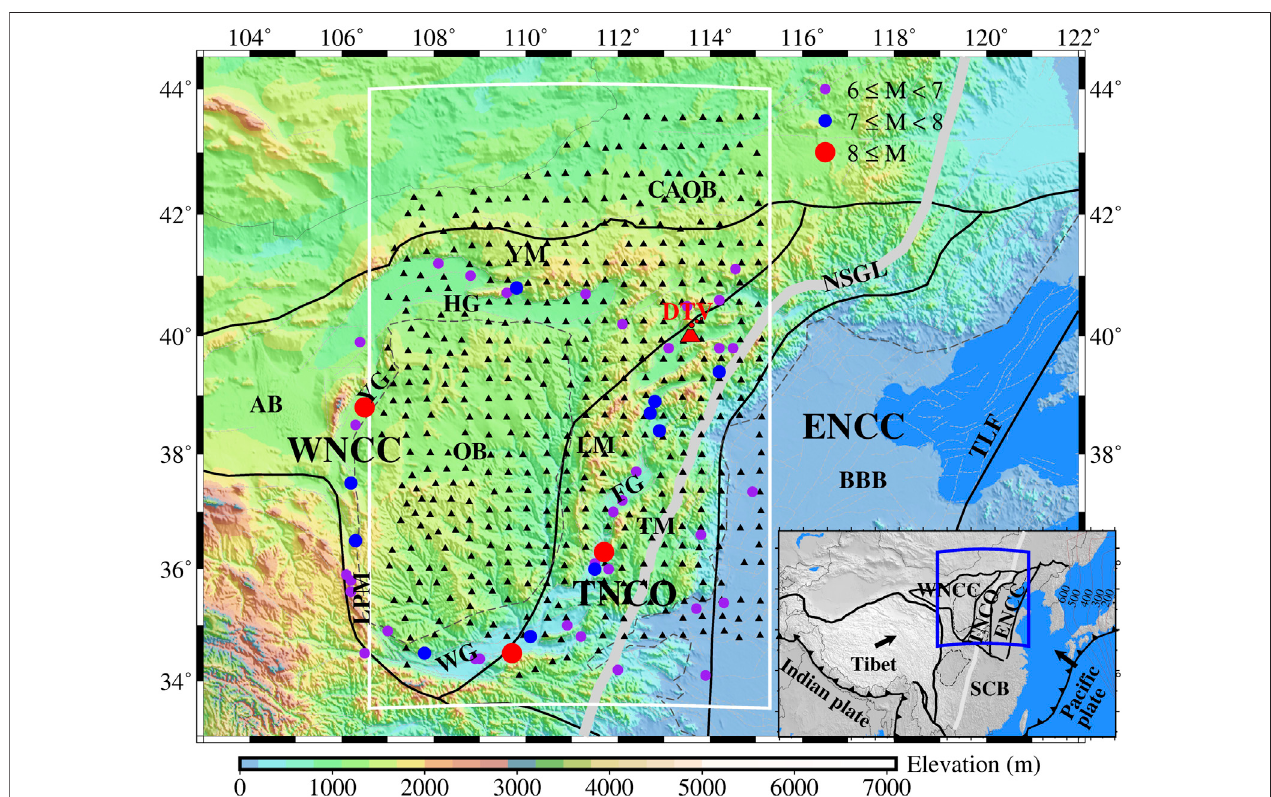
FIGURE 1 | Distribution of seismic stations used in this study. The black triangles represent the seismic stations deployed by ChinArray project. The red volcanic symbol indicates the location of the Datong volcano (DTV). The color circles denote the large historic earthquakes of M ≥ 6 (Liu and Wang, 2012). The thick black lines outline the main tectonic units: the eastern NCC (ENCC), the western NCC (WNCC) and the Trans-North China Orogen (TNCO). The dashed black lines present the boundaries ofthe Ordosblock (OB) and the Bohai bay basin (BBB). The thick gray line indicates the North-South Gravity Line (NSGL). The white rectangle outlines the study area. AB, the Alax black; CAOB, the Central Asia Orogenic Belt; YG, the Yinchuan graben; HG, the Hetao graben; WG, the Weihe graben; FG, the Fenhe graben; LPM, the Liupan mountain; YM, the Yin mountain; LM, the Lüliang mountain; TM, the Taihang mountain; TLF, the Tanlu fault. Inset shows the tectonic setting of theTNCOanditsadjacentareas.SCB,thesouthChinablock.TheblackthickarrowheadindicatestheabsoluteplatemotiondirectionfromGSRMv2.1model(Kreemer et al., 2014).